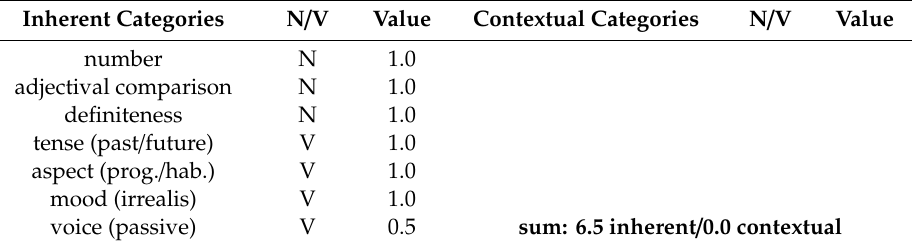
Table 4. The grammatical categories of